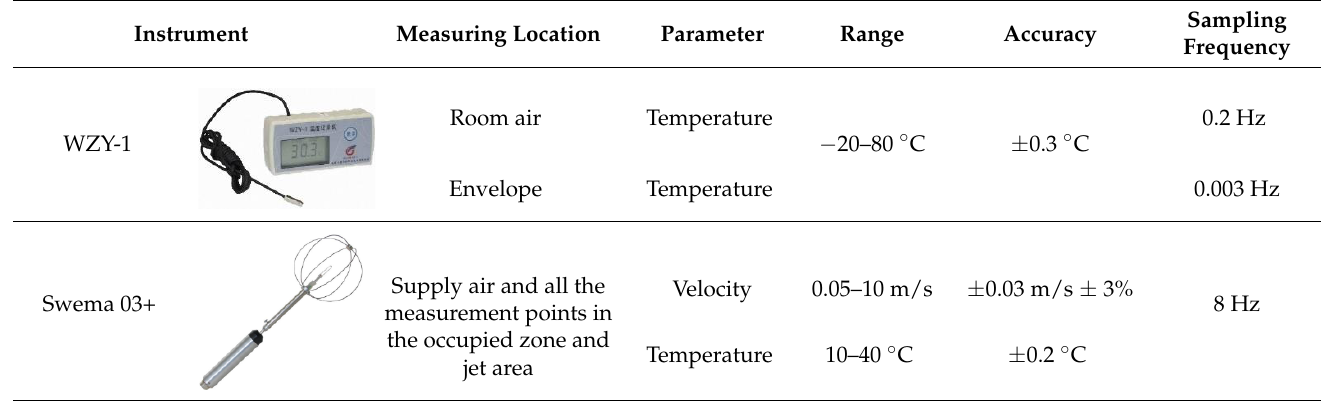
Table 2. Information on the measurement instruments.